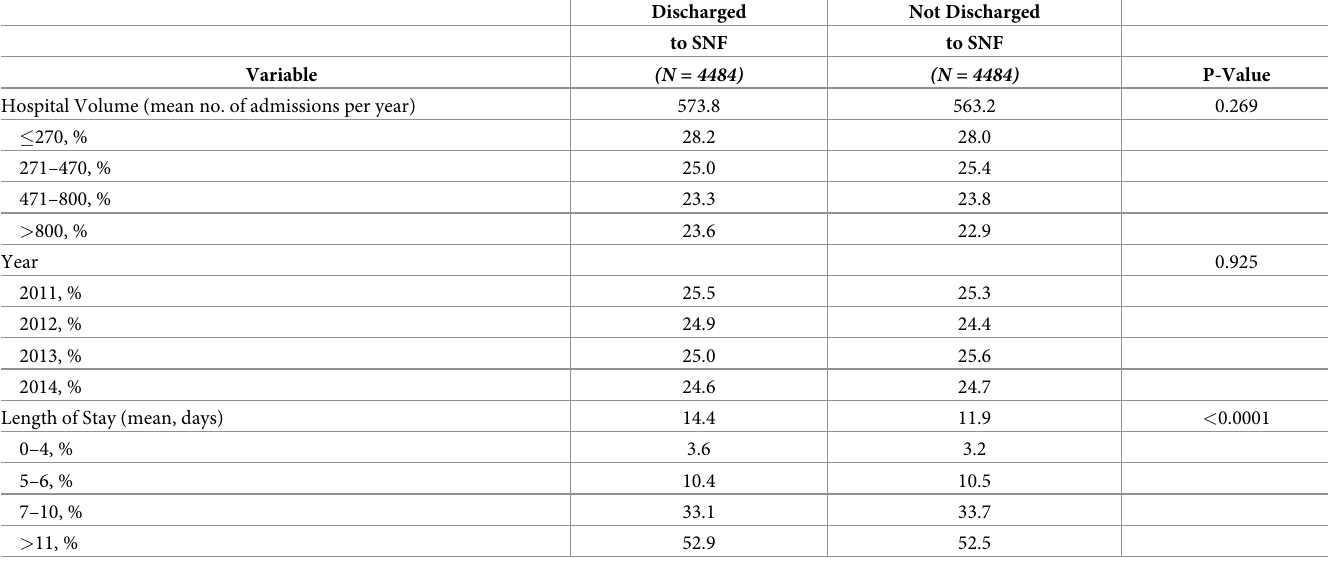
This table shows the characteristics of the patients in our sample, stratified by their post-discharge destination (SNF versus elsewhere), after those discharged to SNF were matched to those discharged to another destination on the set of characteristics included in this table.